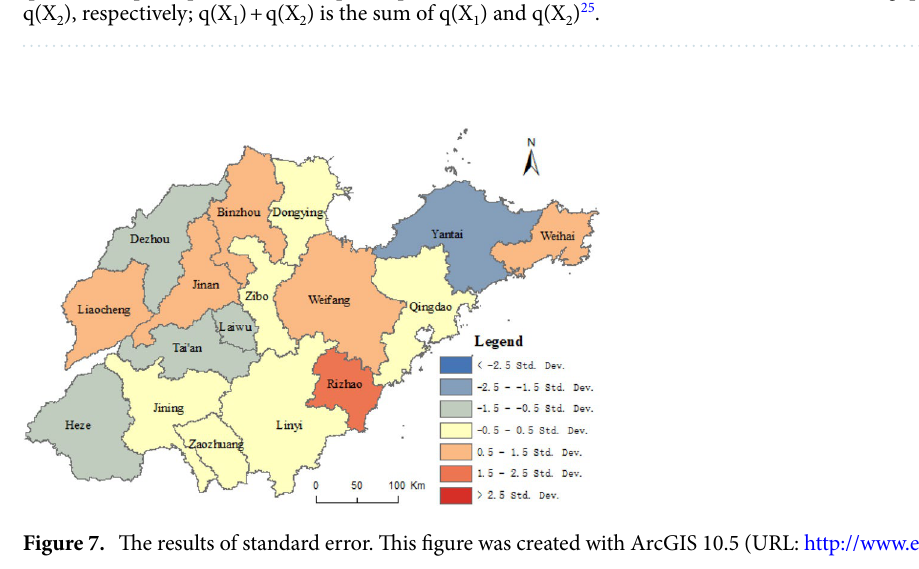
Table 5. Results of interaction between two covariates. q(X 1 ∩ X 2 ) represents the interaction of q(X 1 ) and q(X